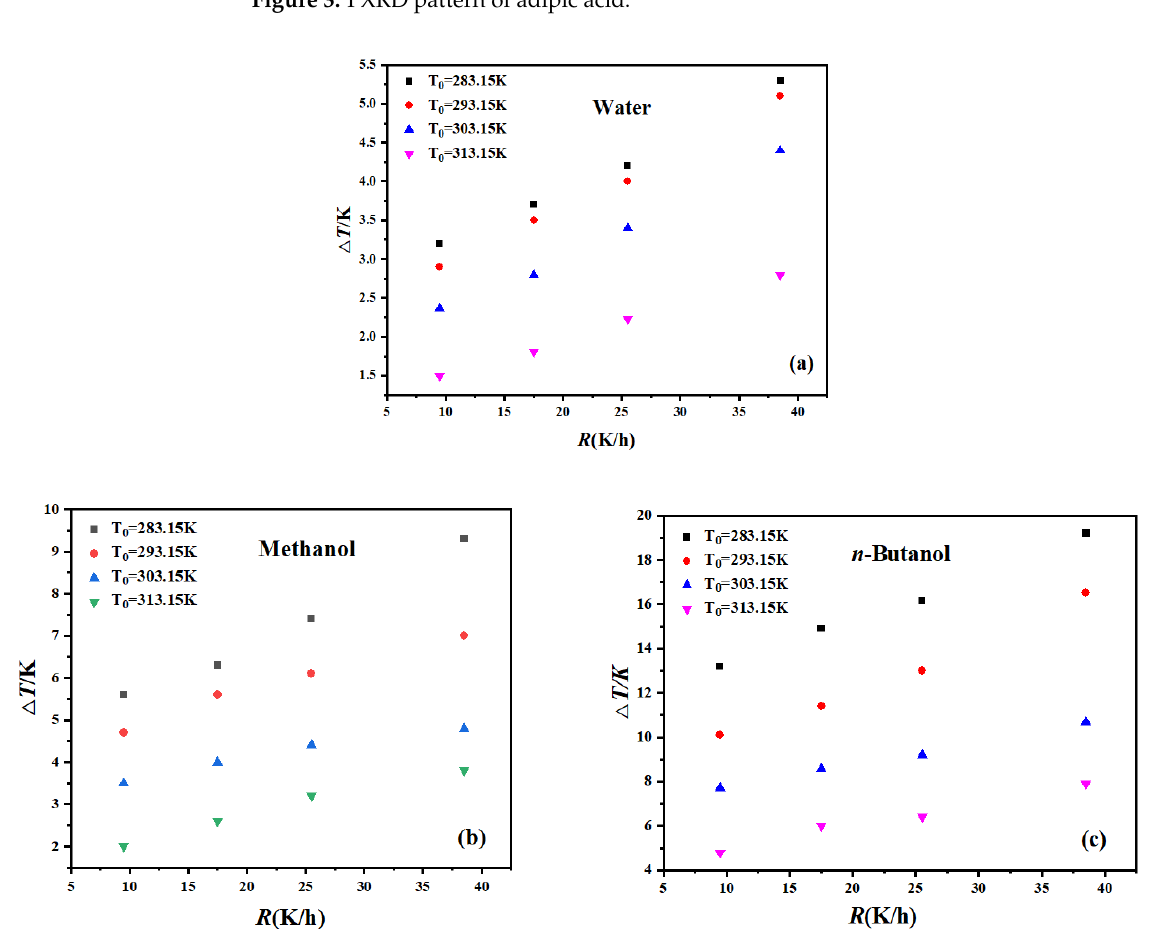
Figure 4. Relationship between MSZW and cooling rate from 283.15 K to 313.15 K ( a ) Water, ( b ) Methanol, ( c ) n -Butanol